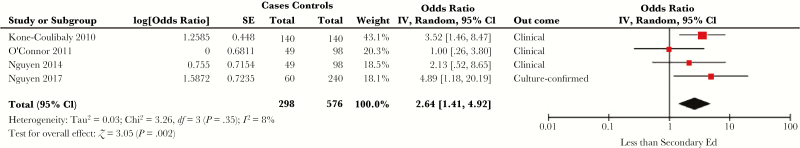
Forest plot of studies included in meta-analysis assessing whether an individual having less than secondary education was associated with symptomatic cholera. The summary odds ratio was calculated using random effects models. Heterogeneity is described using the Cochran Q test and the I2 statistic. Abbreviations: CI, confidence interval; df, degrees of freedom; IV, inverse variance; SE, standard error.